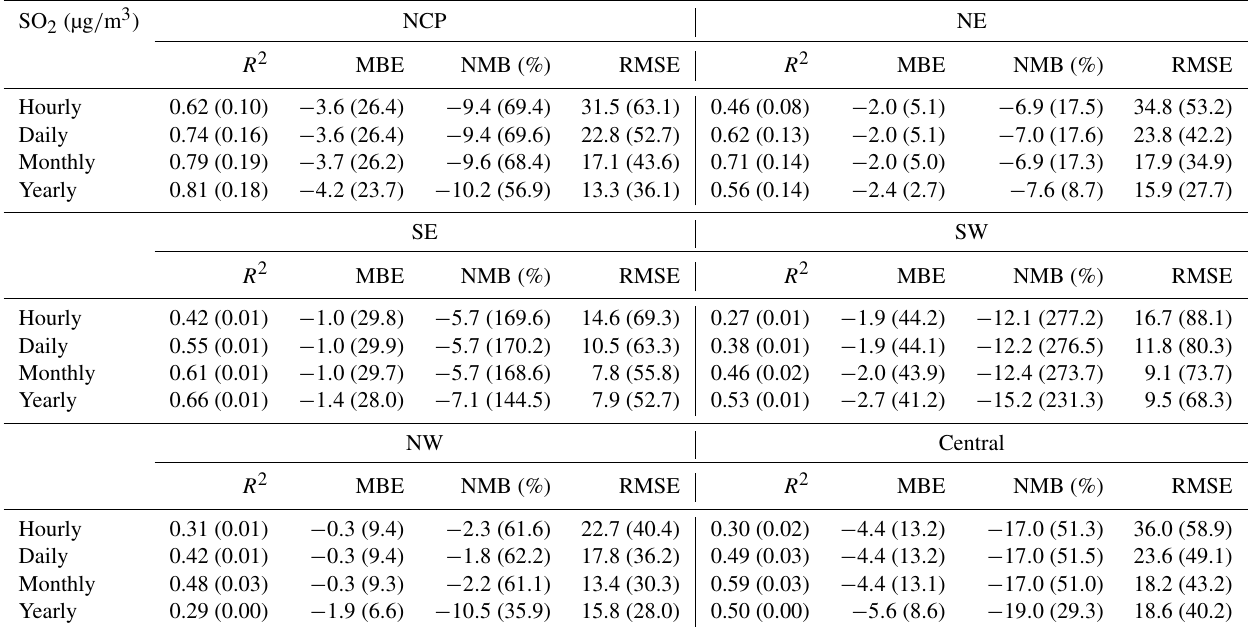
Table E3. CV results of the reanalysis (outside brackets) and base simulation (in brackets) for SO 2 concentrations in different regions of China on different temporal